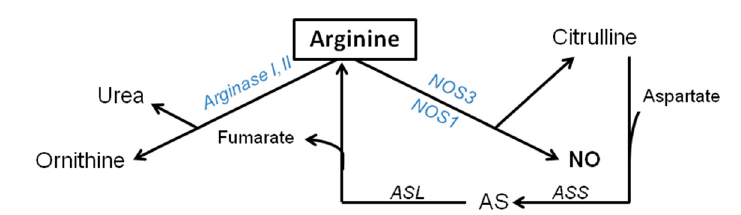
Figure 1. Arginine-citrulline-NO metabolism during physiological conditions. Abbreviations: NO, nitric oxide; NOS3, endothelial nitric oxide synthase; NOS2, inducible nitric oxide synthase; ASS, argininosuccinate synthetase; ASL, argininosuccinate lyase; AS,